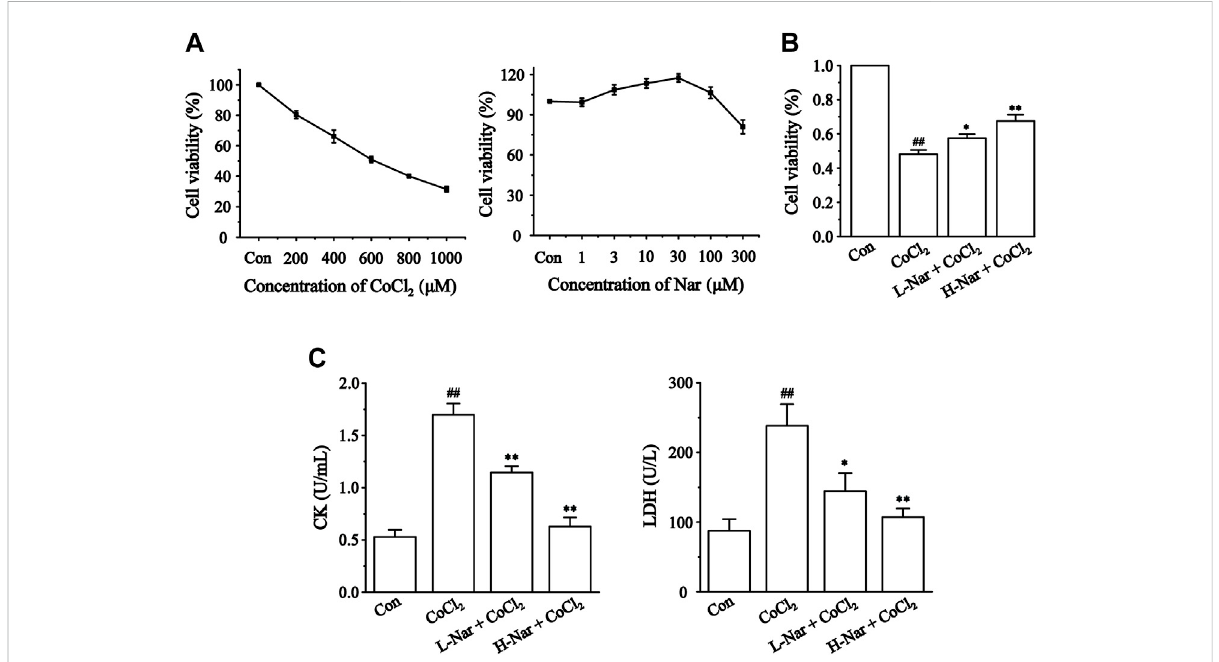
FIGURE 4 EffectsofCoCl 2 andNaronH9c2cellsviability, andtheeffectsofNaronCoCl 2 -inducedcardiomyocyte injury.Viability wasmeasuredbyCCK- 8. (A) H9c2 cells were incubated with CoCl 2 (200 – 1,000 μ M) alone and Nar (1 – 300 μ M) alone for 24 h. (B) Cells were pretreated with Nar (10 and 30 μ M) for 4 hand then exposed with CoCl 2 (600 μ M) for 24 h. (C) The effects of Naron therelease amount ofCK and LDH inH9c2cells. Data were expressed as the mean ± SEM of each group. ## p < 0.01 vs. Con group; * p < 0.05, ** p < 0.01 vs. CoCl 2 group, n = 6 each group. Note: L-Nar: 10 μ M and H-Nar: 30 μ M.